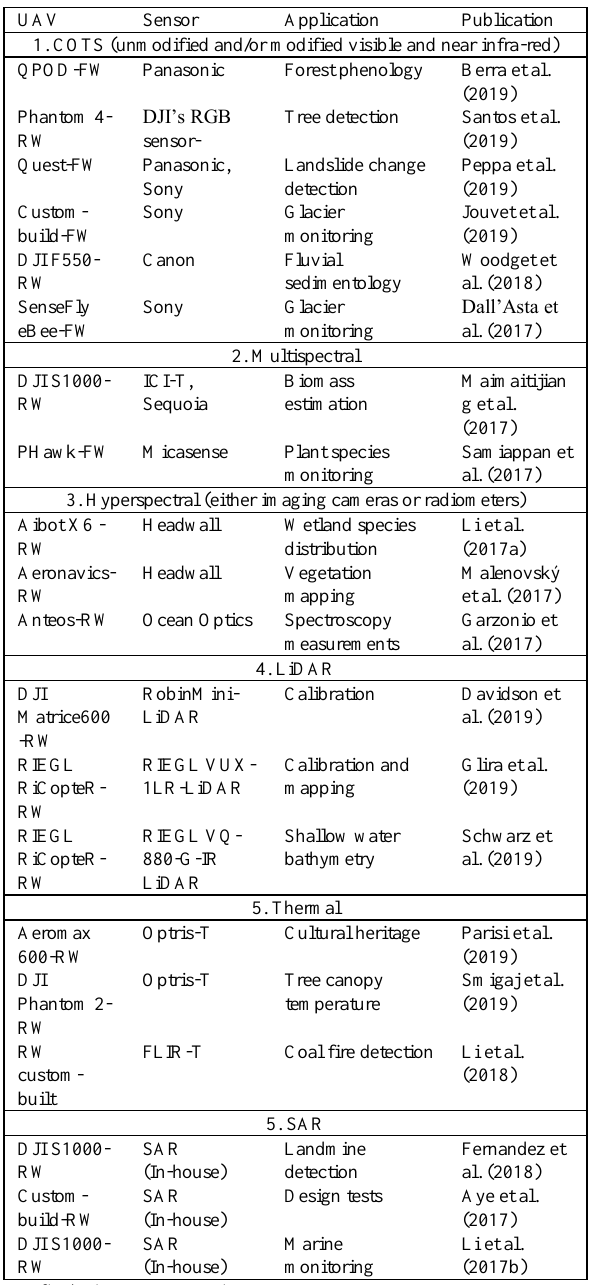
Table 1. Various UAV platforms and sensor models used for a wide spectrum of applications.